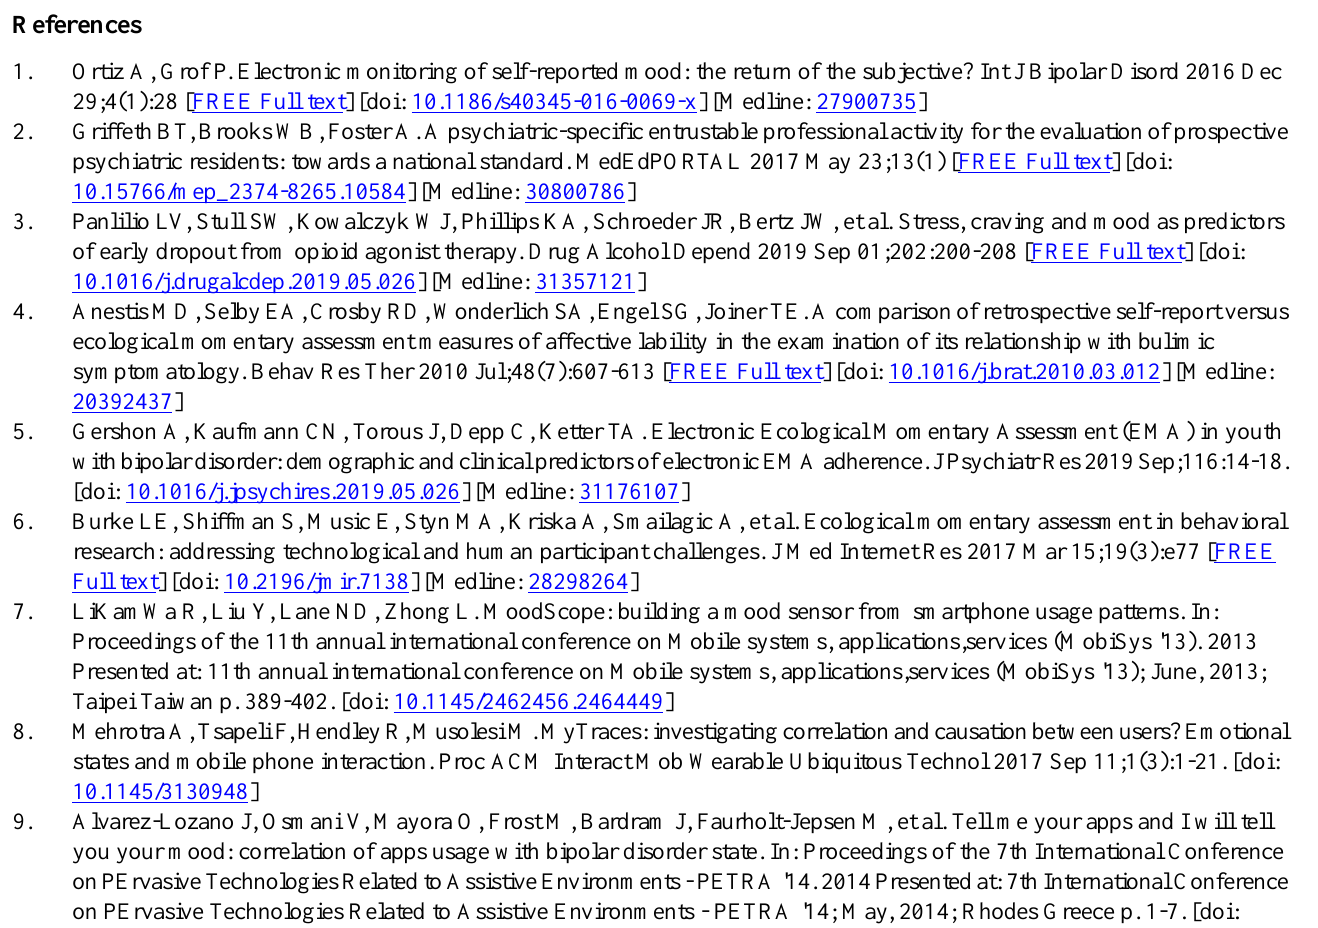
Experiments section, for both the 3-class and 5-class experiments using the mixture model for missing data imputation and feature